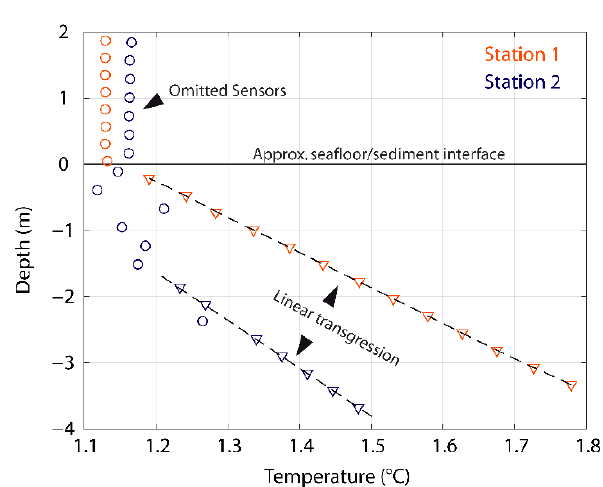
Figure 4. In situ temperature readings of the individual sensors with depth in the sediment for two example stations after the frictional heat decay. The temperature gradient is obtained from a linear transgression through the data points. Triangles mark sensor readings used for thermal gradient calculations and circles mark omitted sensors.